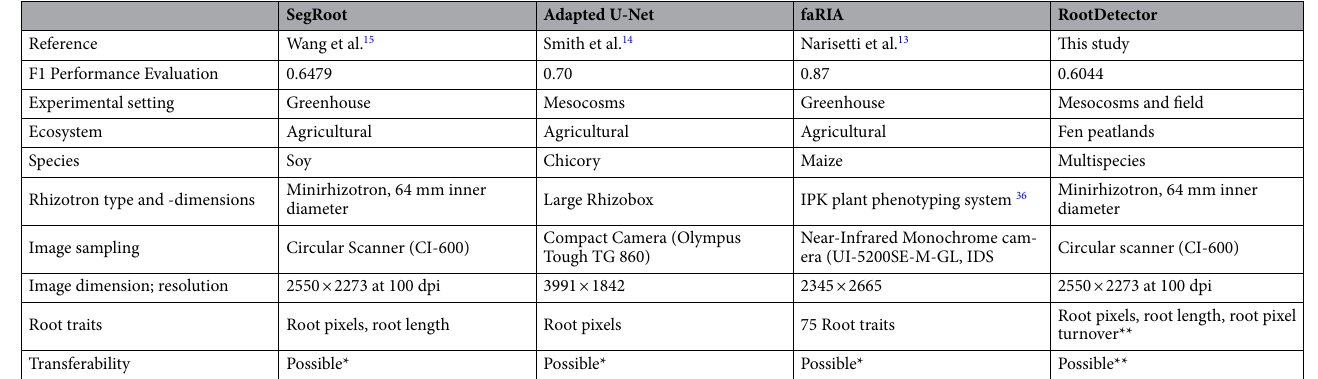
Table 1. Comparison of recent CNN-based root detection tools in terms of development and functionality. *Possible according to source publication. **Transfer to other ecosystems and in-depth retraining options as well as module for assessment of turnover in time series to be published